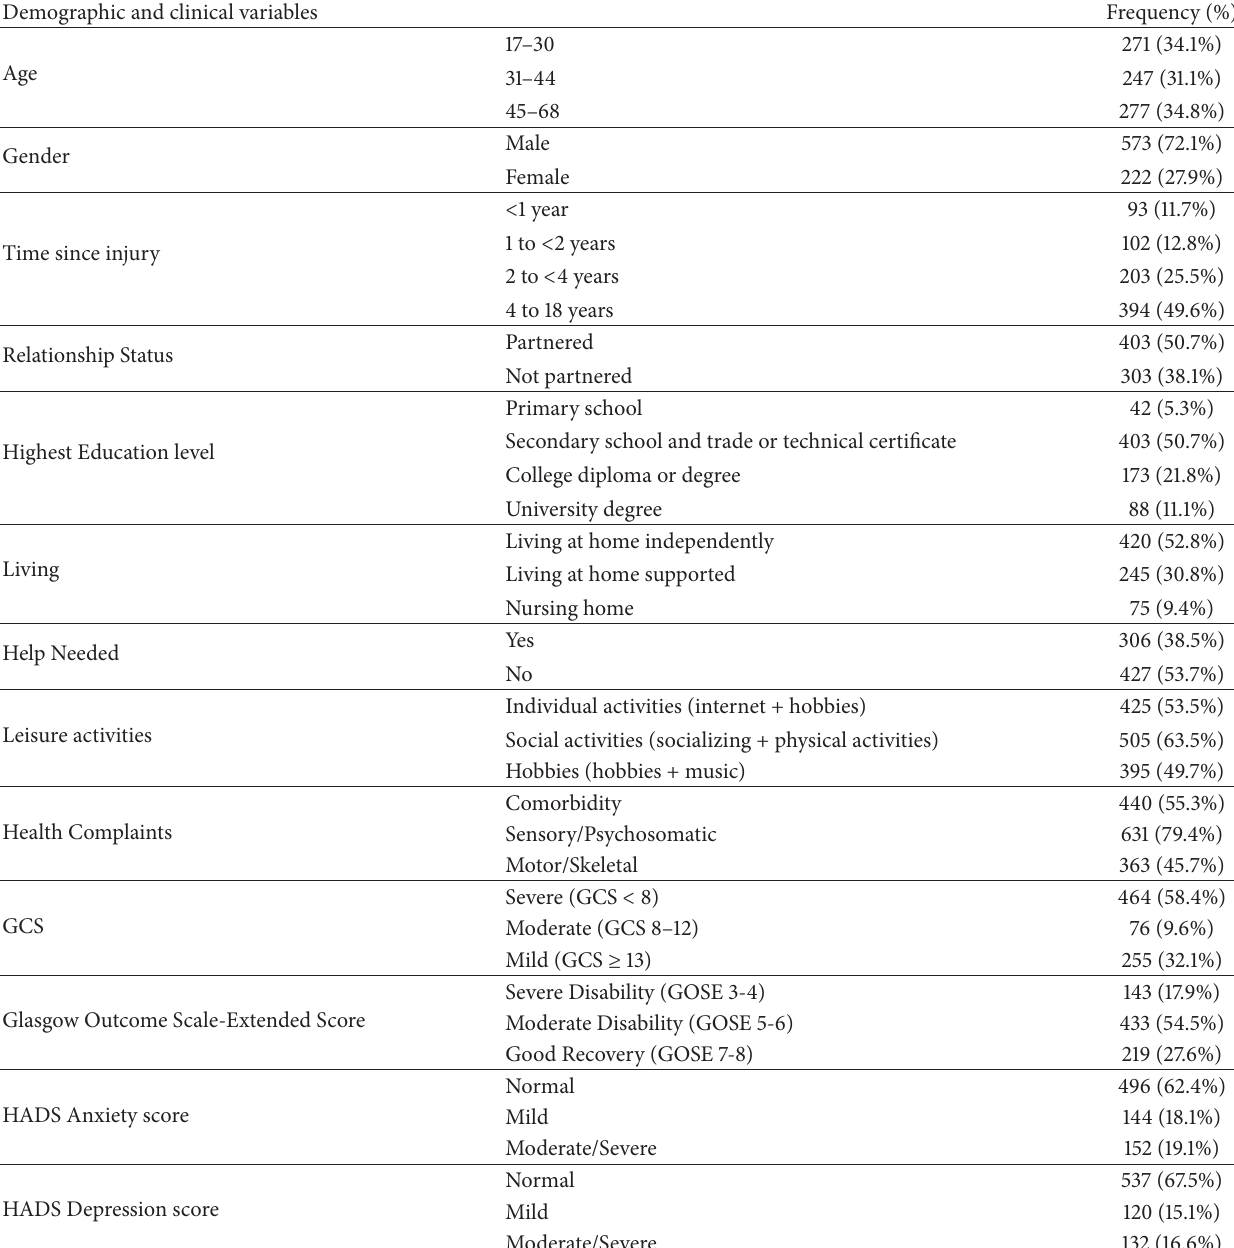
Table 1: Demographic and clinical characteristics of the TBI